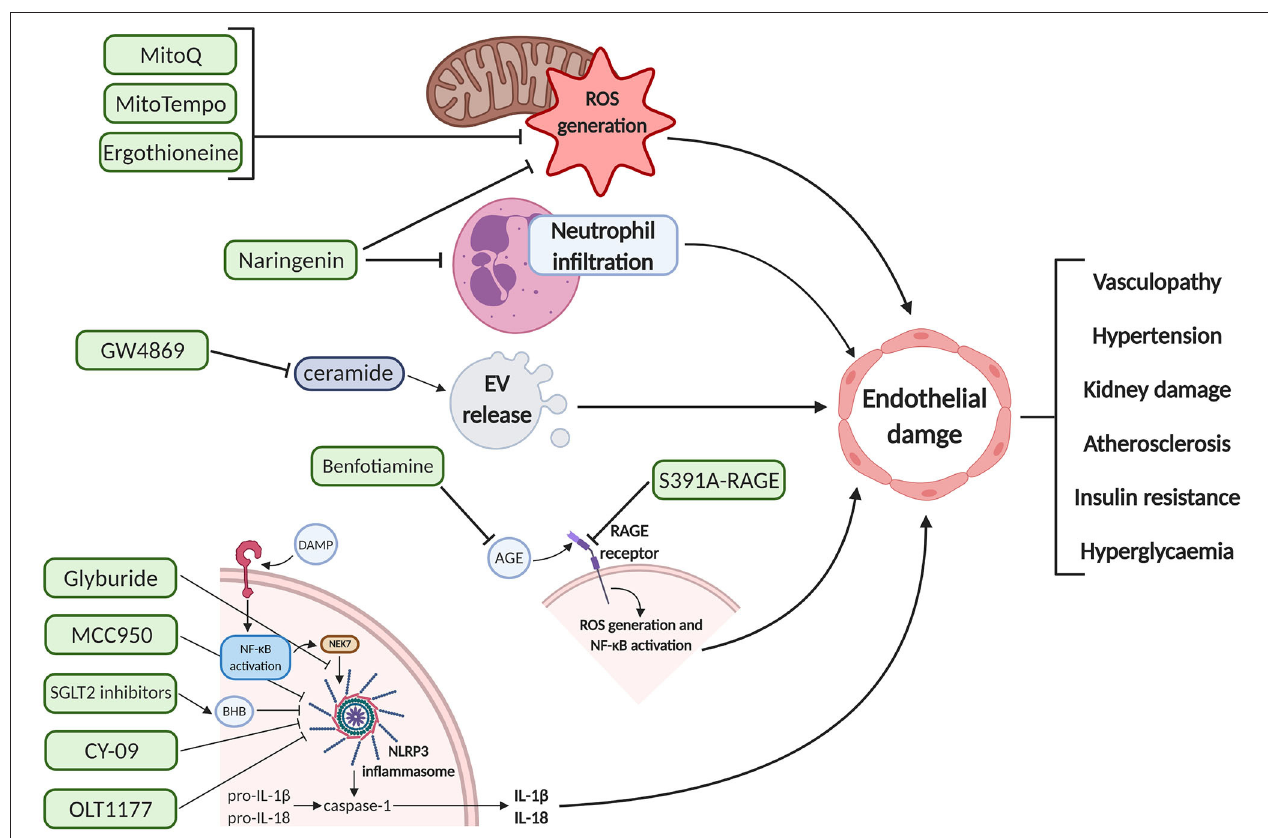
FIGURE 2 | Schematic diagram of the pharmacodynamics of various proposed therapeutic interventions for endothelial damage prophylaxis. These agents can inhibit deleterious pathways upstream of endothelial cell dysfunction, potentially preventing the maternal clinical manifestations associated with pre-eclampsia and gestational diabetes mellitus. Created with BioRender.com. EV, extracellular vesicle; ROS, reactive oxygen species; DAMP, damage-associated molecular pattern; NF- κ B, nuclear factor kappa-light-chain-enhancer of activated B cells; NEK7, NIMA related kinase 7; NLRP3, NOD-; LRR,- and pyrin domain-containing protein 3; BHB, beta-hydroxybutyrate; IL, interleukin; AGE, advanced glycation end products; RAGE, receptor for